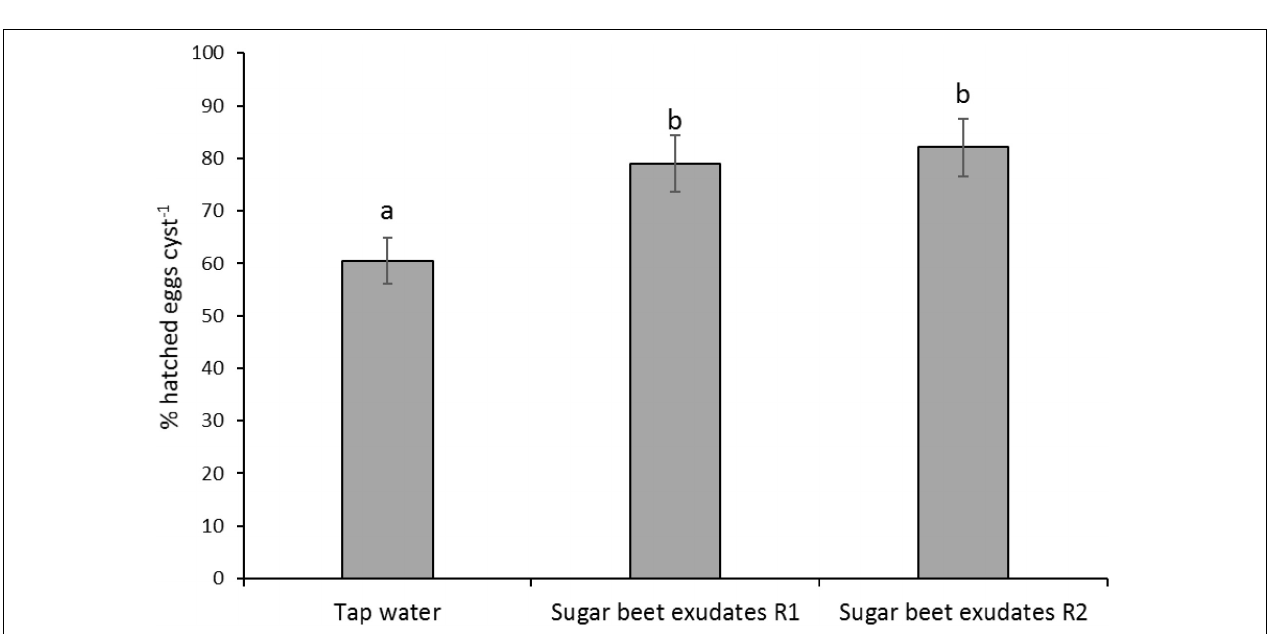
FIGURE 4 | Hatching of Heterodera carotae at 10 or 20 cm soil depth following application of root exudates from Daucus carota cv. Pusa kesa or Touchon from top soil at 50 or 100% concentration of the crude root exudates as compared with tap water. Different lowercase letters above the error bars represent significant differences between treatments at the same soil depth according to Tukey test (5% significance level).